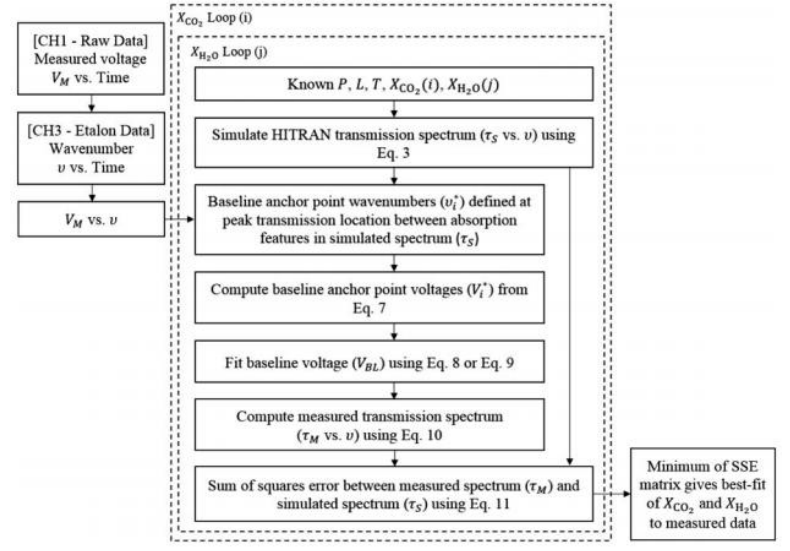
Figure 12. Flow chart for DAS baseline fitting data analysis. Figure adapted from [99].